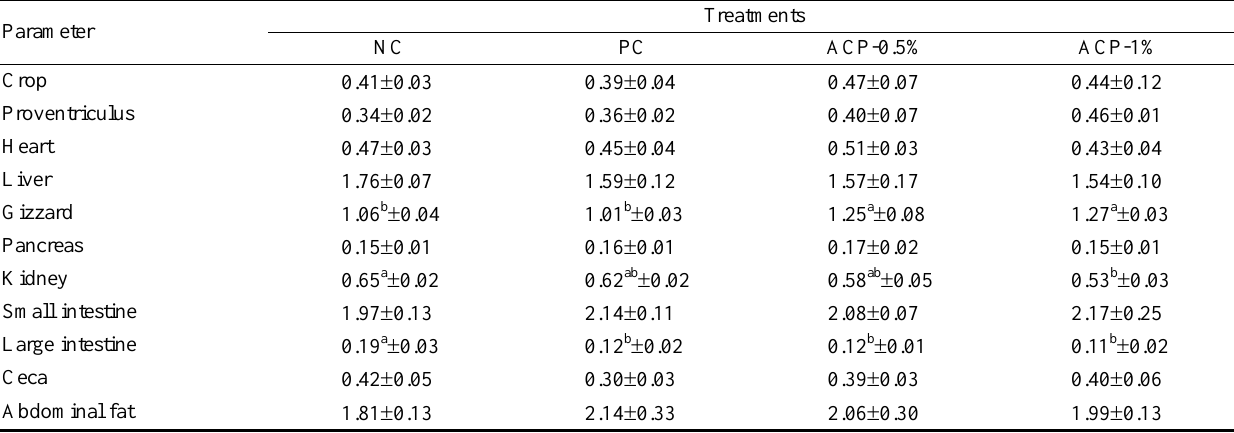
Table 5. Effect of Alisma canaliculatum with probiotics on relative internal organ weights of broilers (percentage in relation to body weight) (n = 15 for each treatment)